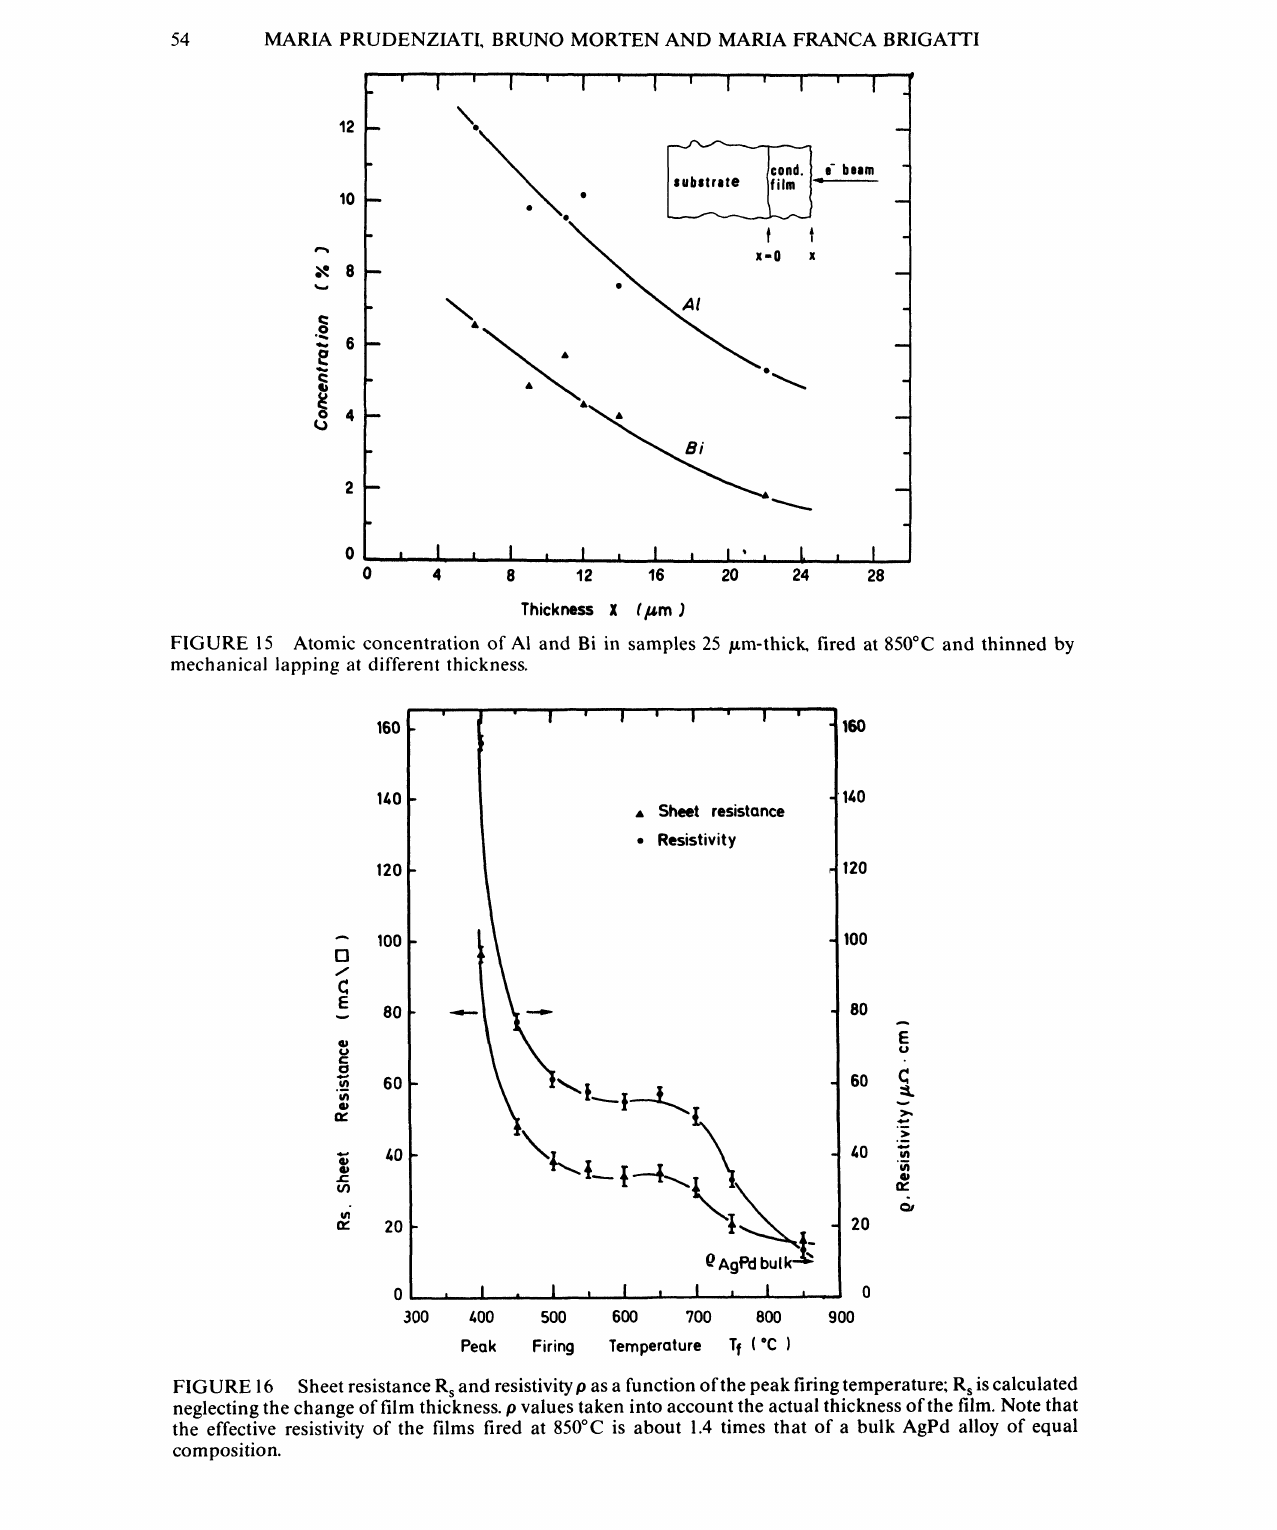
Sheet resistance R and resistivity p as a function ofthe peak firing temperature; R is calculated neglecting the change of film thickness, p values taken into account the actual thickness ofthe film. Note that the effective resistivity of the films fired at 850C is about 1.4 times that of a bulk AgPd alloy of equal